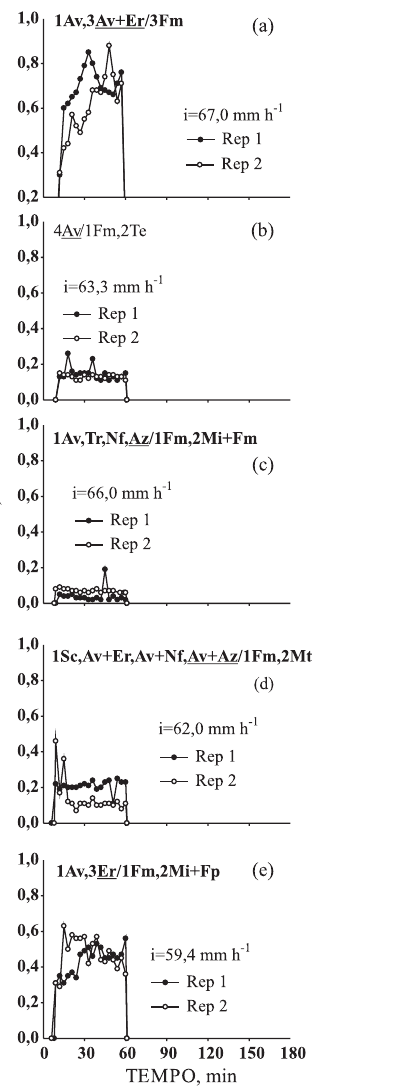
Figura 4. Concentrações instantâneas de sedimento na enxurrada (CSE) no segundo (T2: solo não imobilizado, raízes mortas, crosta rompida, 18 % coberto – figuras (a) a (e), à esquerda) e no terceiro (T3: solo não imobilizado, raízes mortas, crosta recente, 18 % coberto – figuras (f) a (j), à direita) teste de erosão com chuva simulada, nas sequências culturais estudadas (Av: aveia-preta, Er: ervilhaca, Fm: feijão-miúdo, Te: teosinto, Tr: trevo-calypso, Nf: nabo forrageiro, Az: azevém, Mi: milho, Sc: sem cultivo, Mt: milheto e Fp: feijão-de-porco). Valores individuais para cada repetição dos tratamentos (Rep 1 e Rep